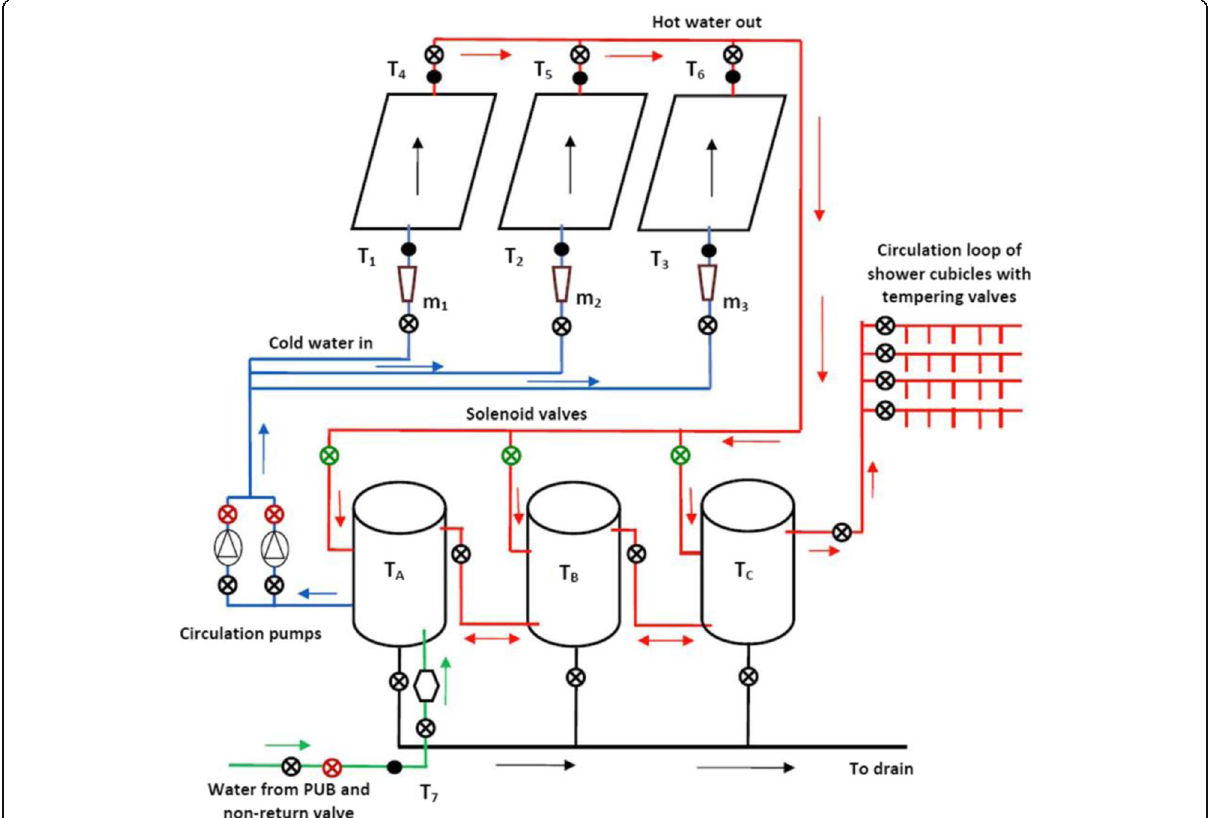
Fig. 1 Schematic layout of water flow loop between storage tanks and PVT